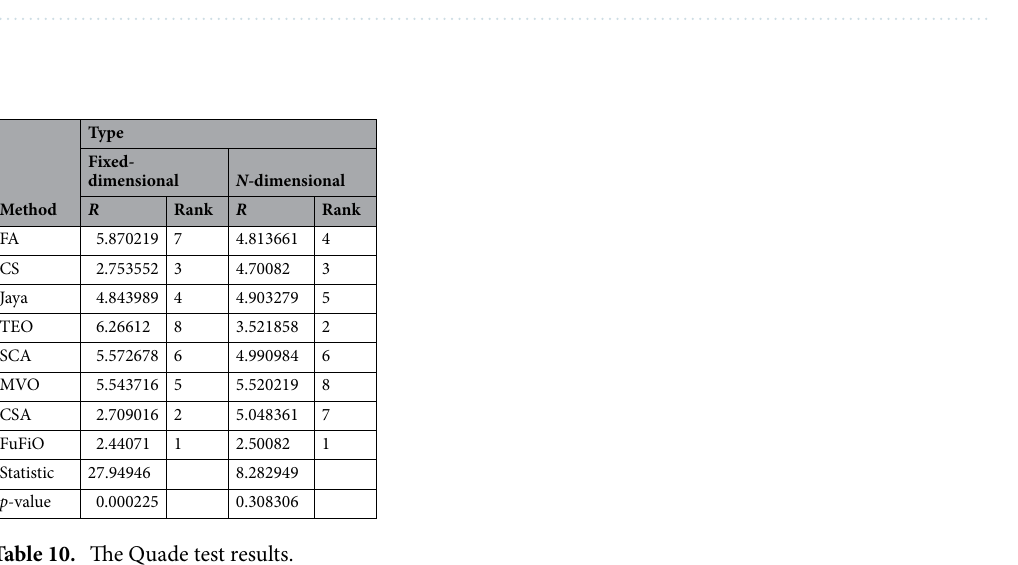
Table 9. The Friedman aligned ranks test results.